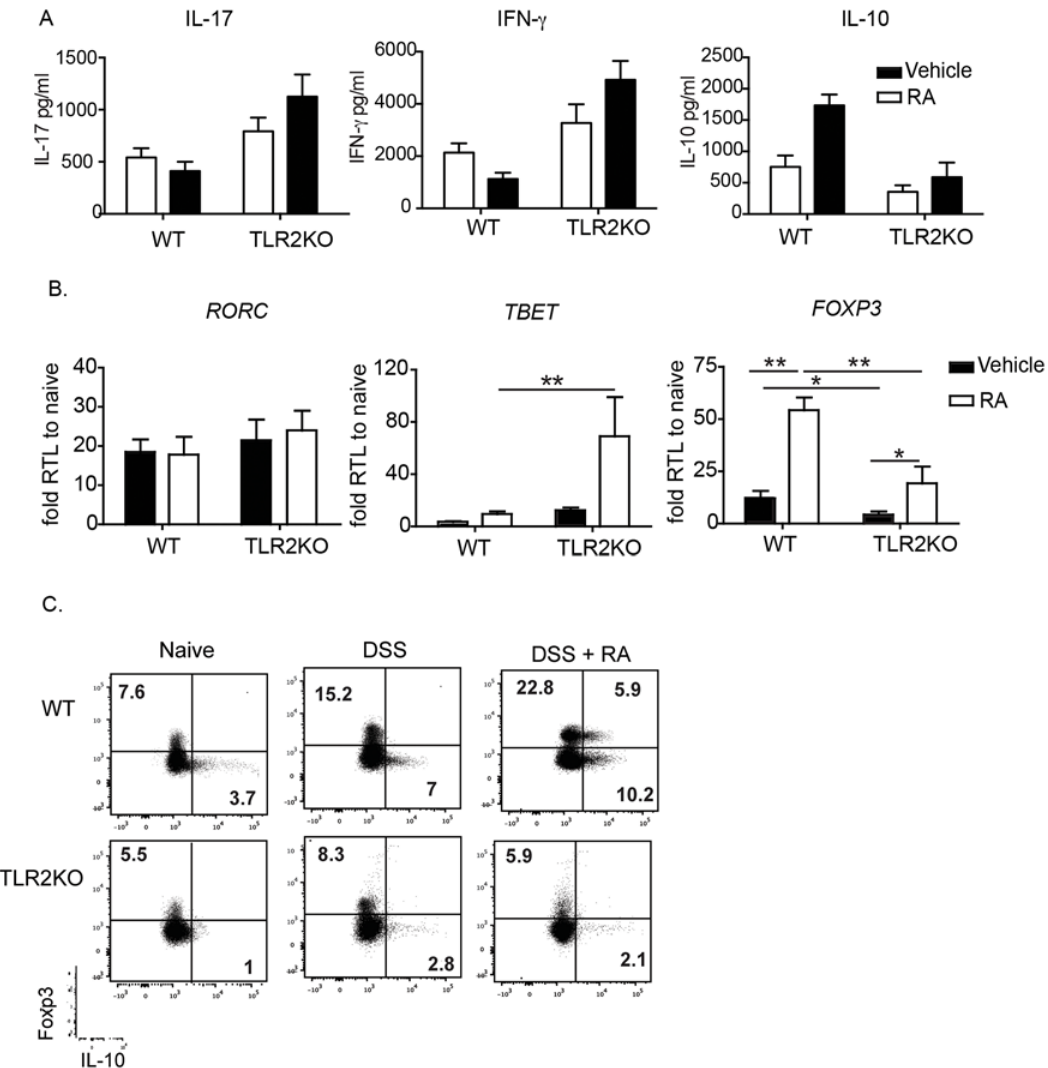
Fig 2. RA treatment suppresses IFN- γ during DSS in WT mice but enhances their secretion in TLR2KO mice. (A) Mucosal scrapings from mice receiving the DSS and water were harvested on day 10 and analyzed by ELISA for cytokine levels. (B) Quantitative RT-PCR for transcription factors associated with T helper subsets were also performed on colonic lamina propria samples taken at day 14. Data shown are the fold increase of Vehicle- and RA-treated mice compared to naive controls. Data are the mean ± SEM of 5 – 8 mice per group pooled from two independent experiments. (C) Expression of Foxp3 and IL-10 in colonic LP CD4 + T cells (n = 3 per group), one representative facs plot is shown. * , p < 0.05, ** , p < 0.01 using Student ’ s